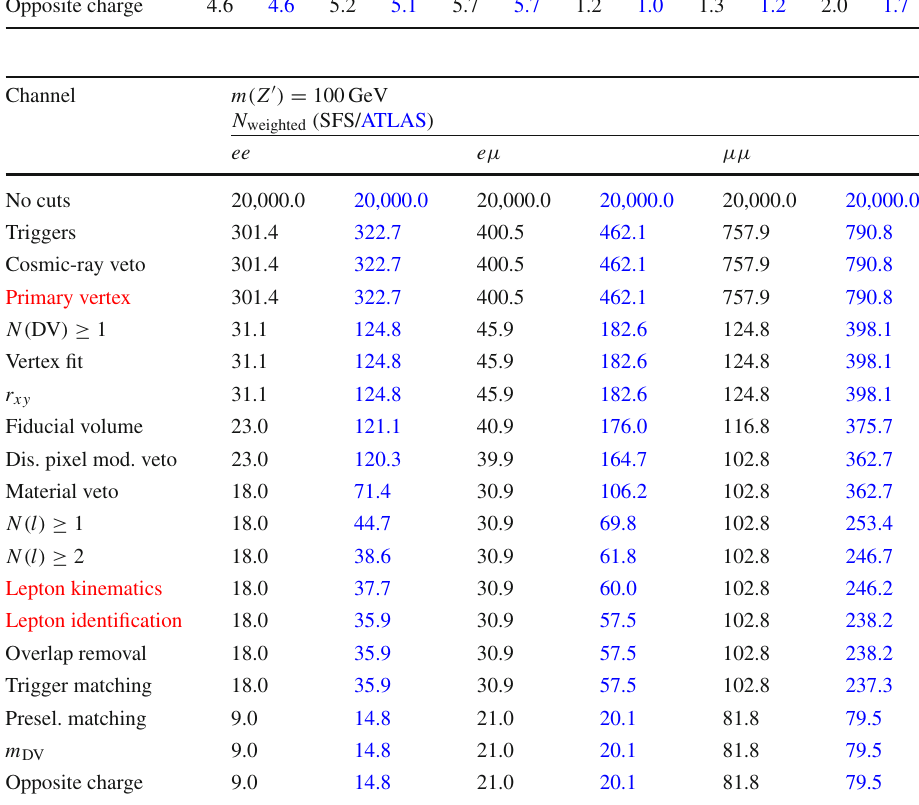
Table 6 Cutflow tables for two RPV SUSY scenarios in which all decays induced by the λ 121 and λ 122 couplings are included with an equal branching ratio. We classify the results according to the flavour of the leptons originating from the displaced vertices, the neutralino proper decay lengths are fixed to 30mm (left) and 1000mm (right), and the squark and neutralino masses are respectively fixed to 1600GeV and 1300GeV in both cases. The numbers N weighted are reweighted to match to